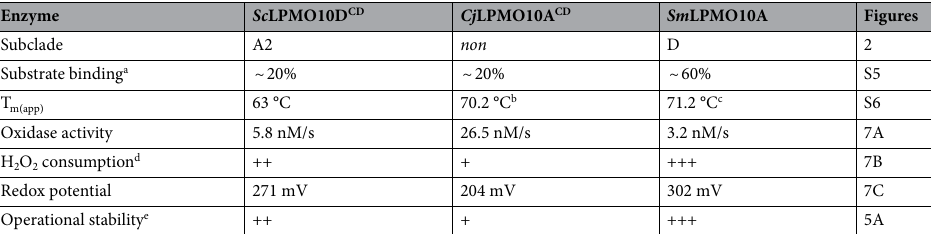
Table 3. Overview of the properties of three phylogenetically distinct chitin-oxidizing LPMOs. a Measured as protein adsorbed to the substrate after 2 h incubation (see Figure S5). b Data from a previous study by Madland et al. 51 ; pH = 7.0 c Data from a previous study by Jensen et al. 47 ; pH = 6.0 d Initial activity in the 2,6-DMP assay; shown as highest (+++) to lowest (+). e Stability under turnover conditions; shown as highest (+++) to lowest (+).